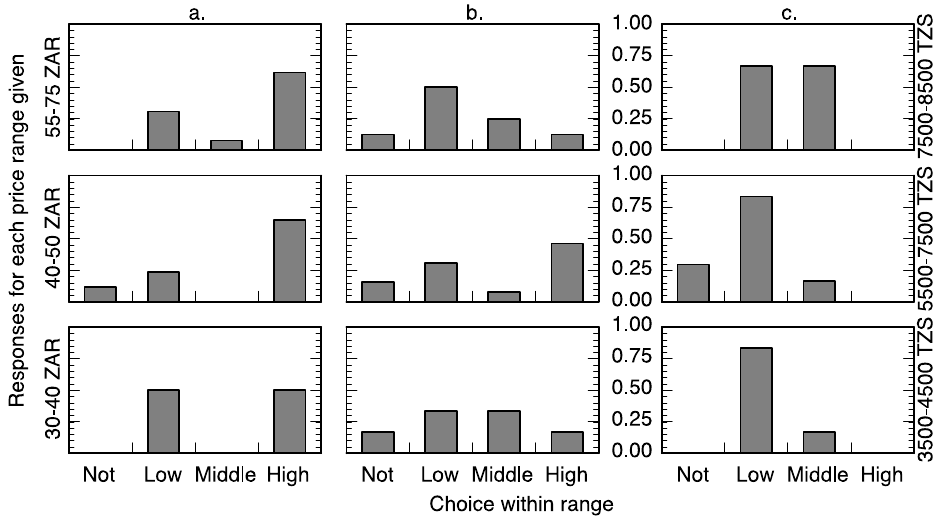
Figure 12. Responses to the question provided in the vernacular, “how much would you pay for this technology?” (willingness-to-pay) with three prices given, in descending order, or “would not purchase” in community A. The three ranges based on the cost of production of the product: below cost, at cost, and above cost. Each range had three prices. Houses were randomly assigned which range of prices would be asked and each range included three prices.